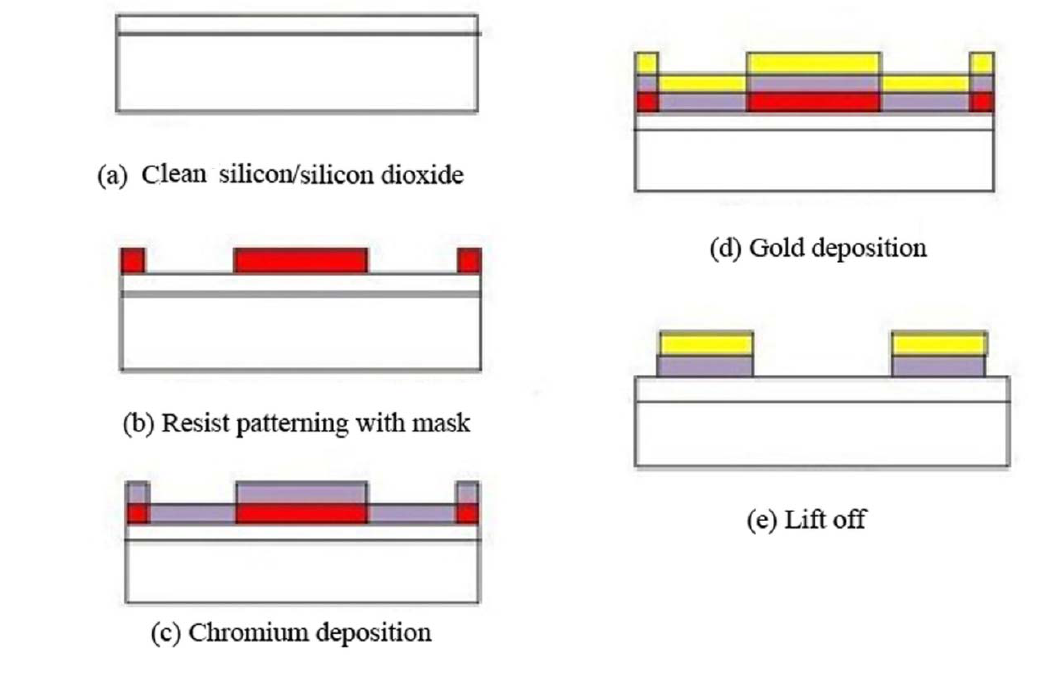
Figure 1. Schematic diagram showing the sample preparation. ( a ) The sample preparation. (RCA); ( b ) The photoresist deposition and UV-exposure through the mask; ( c ) Chorumum deposition; ( d ) Gold deposition; ( e ) Lift off